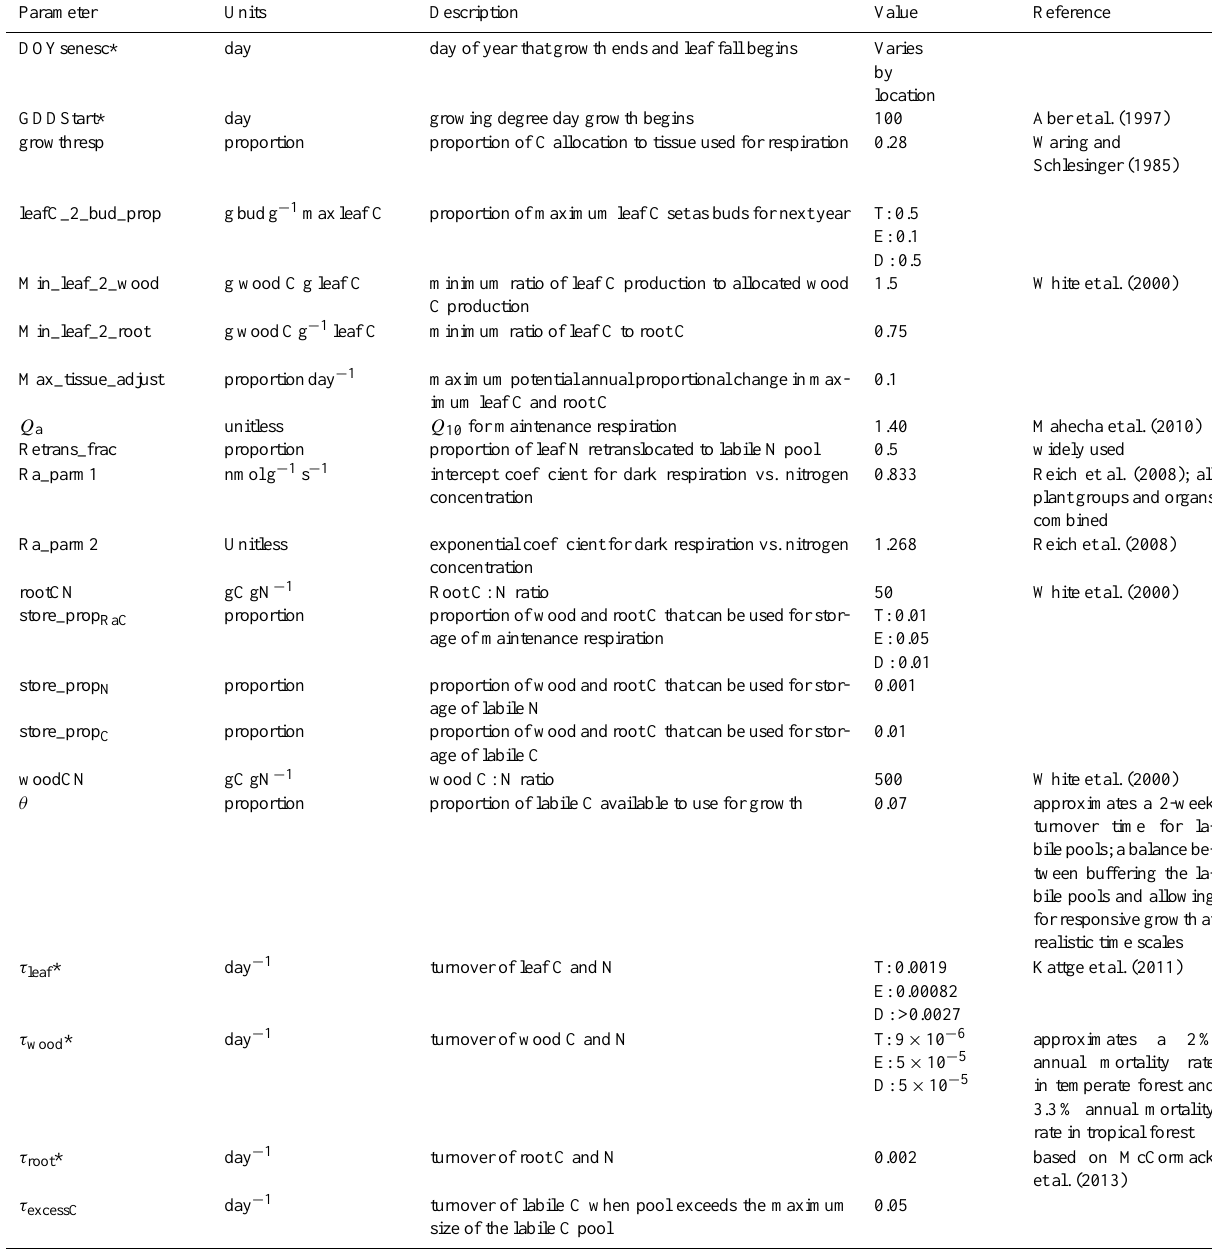
Table 5. Plant allocation and turnover parameters, including units, nominal values and their sources. *indicates that a parameter is also used in the DALEC-C